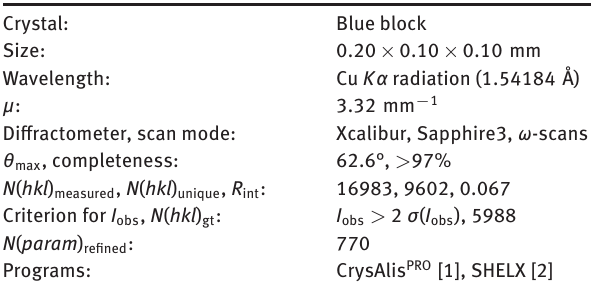
Table 1: Data collection and handling.